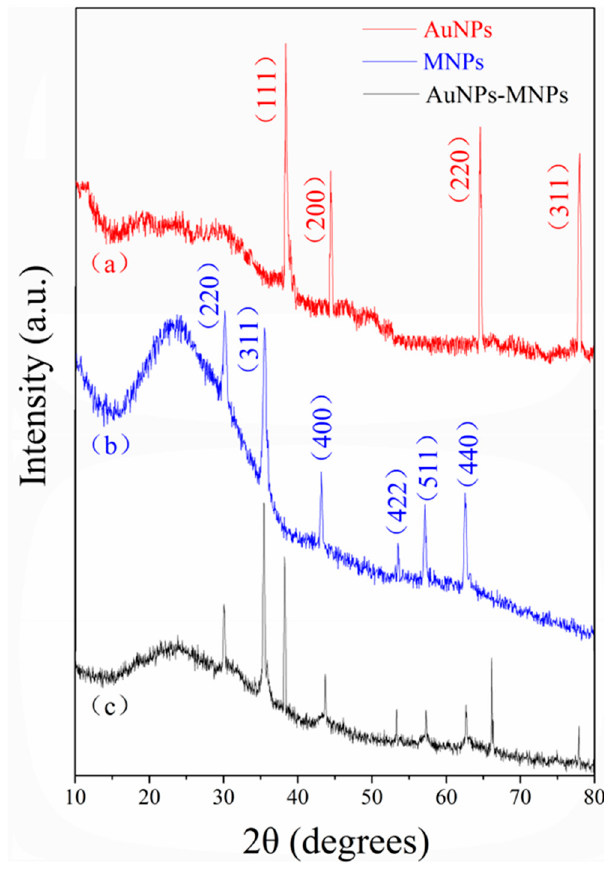
Figure 3. XRD patterns for ( a ) AuNPs, ( b ) MNPs, and ( c ) Fe 3 O 4 @Au nanocomposites.